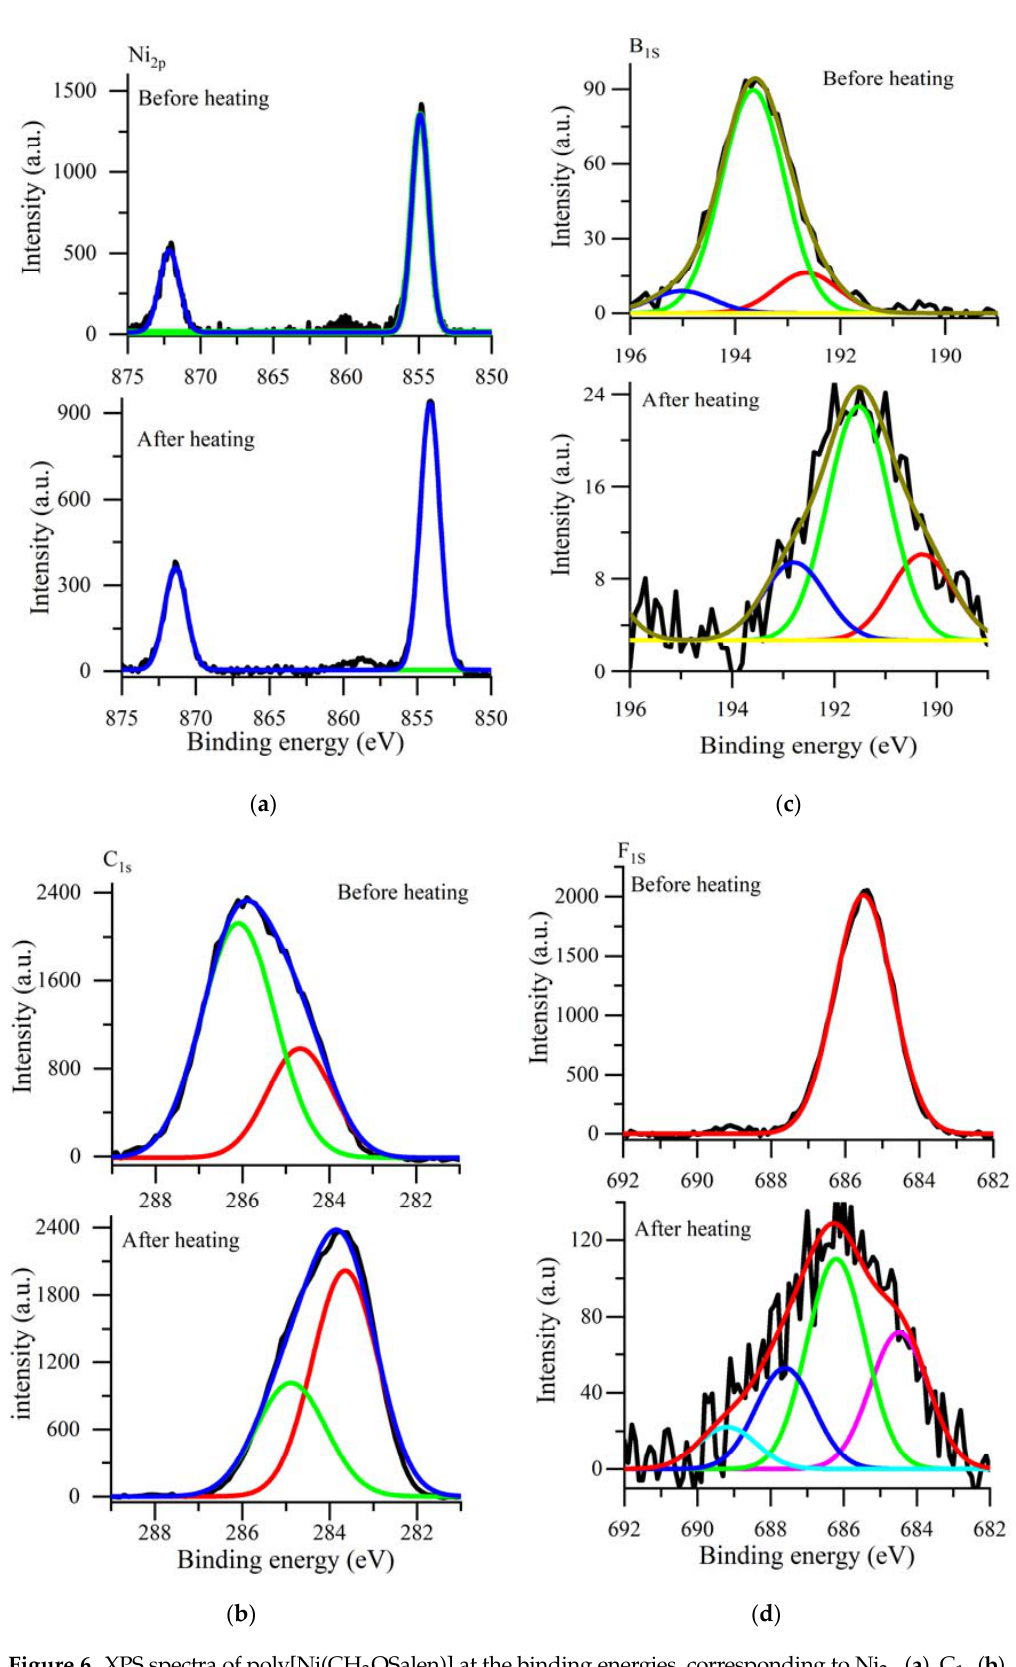
Figure 6. XPS spectra of poly[Ni(CH 3 OSalen)] at the binding energies, corresponding to Ni 2p ( a ), C 1s ( b ), B 1s ( c ), F 1s ( d ). (Black lines are the experimental results; colored lines are the results fitted with Gaussian)